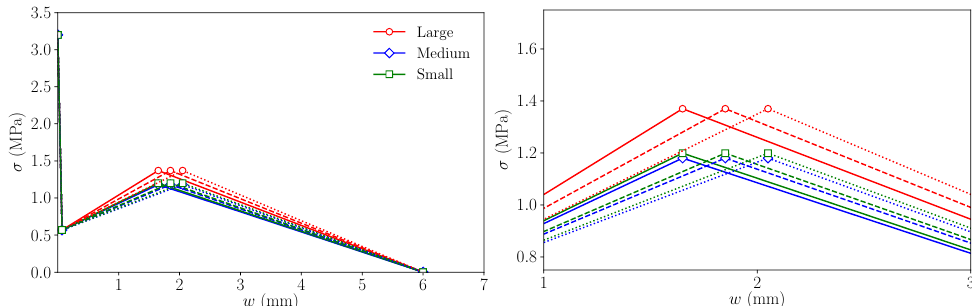
Figure 9. Left : trilinear diagrams used to study the influence of w r on the numerical simulations; right : detail of the diagrams around point r (see Figure 3). Continuous lines represent the trilinear functions with w r = 1.65, dashed lines the functions with w r = 1.85, and dotted lines the function with w r = 2.05.